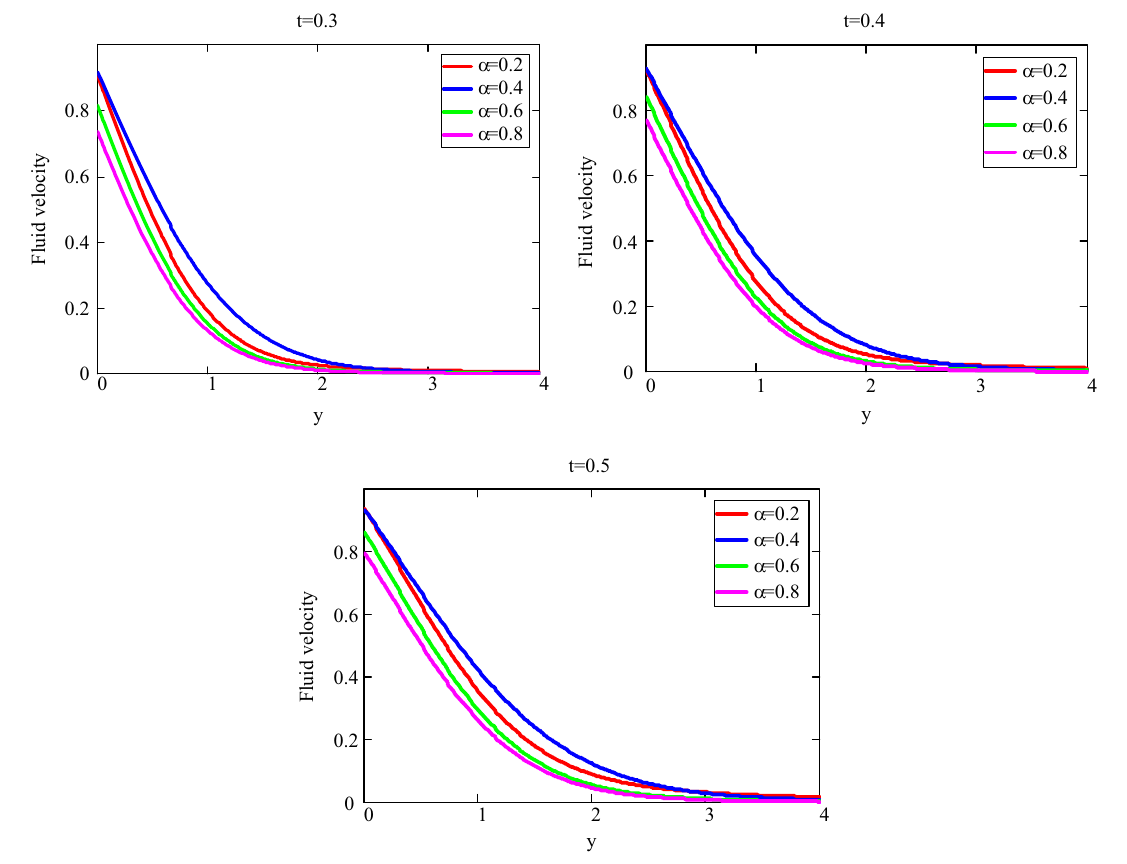
Figure 3: The velocity for the variants of a fractional factor for di ff erent